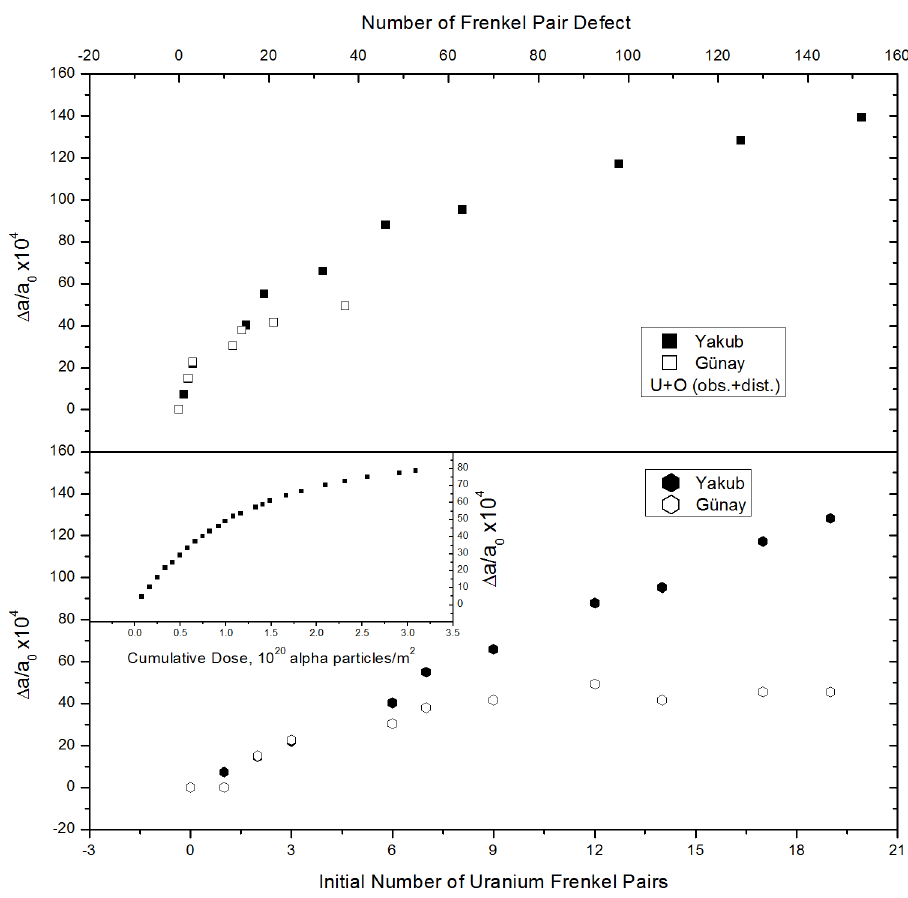
Fig 8. Relative lattice expansions. (a) Total number of defects after equilibration and (b) initial number of uranium FPs. The inset was taken from Ref. 21 and presents experimental lattice expansion data as a function of cumulative